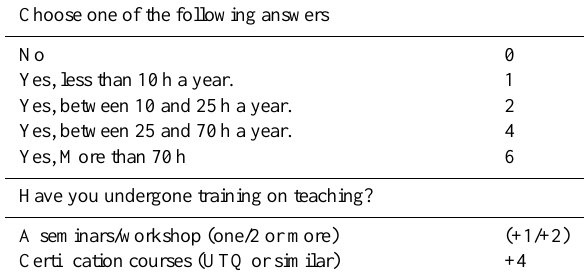
Table A4. Correlations among teaching styles (Survey 1) for faculty without significant didactic training (27 samples, significant (5%) correlations >